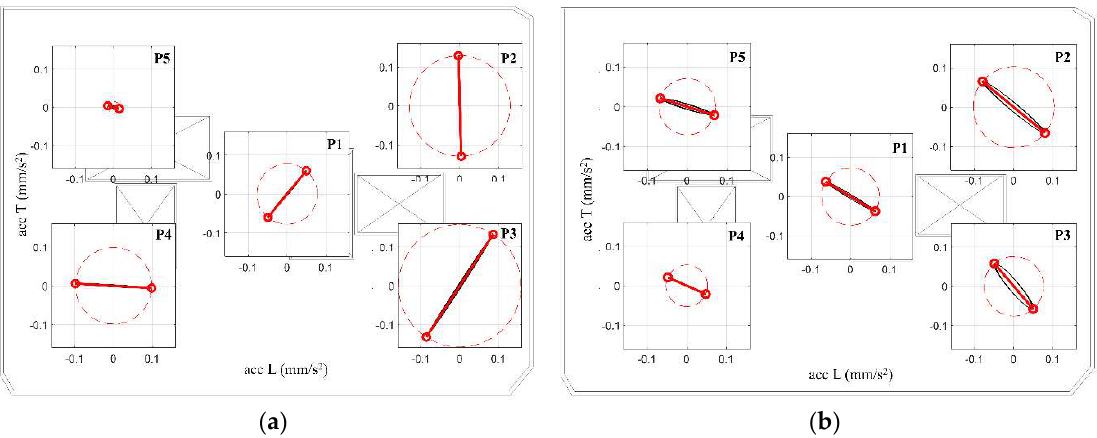
Figure 18. Particle movement plot of the acceleration for the five points measured on the roof of the “La Viña” building. ( a ) The first mode of vibration at a frequency of 2.49 Hz (filtered between 2.485 and 2.495 Hz); ( b ) the second mode of vibration at a frequency 2.79 Hz (filtered between 2.785 and 2.795 Hz).